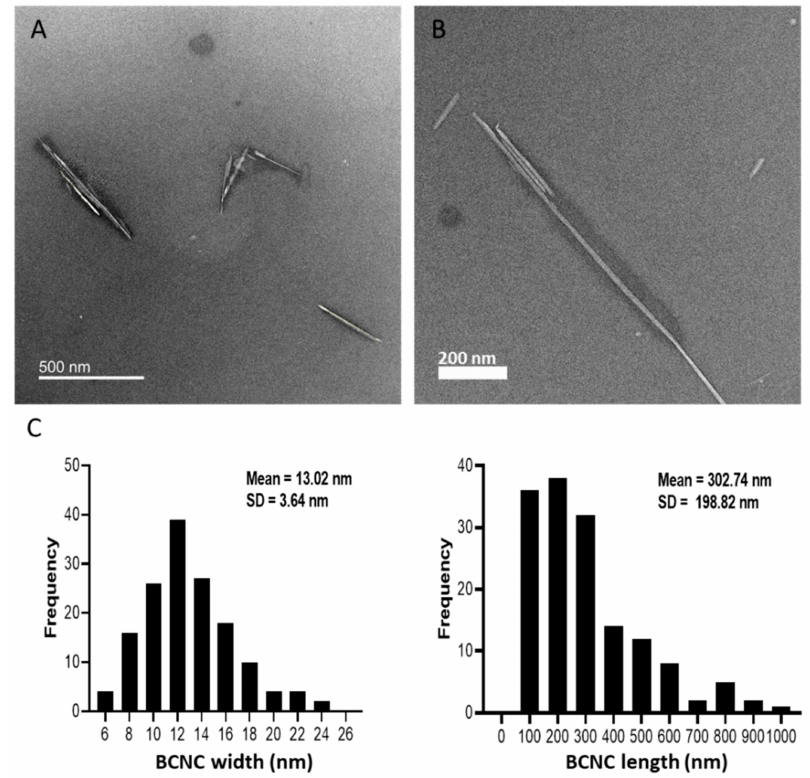
Figure 2. ( A , B ) TEM micrographs of the BCNC prepared by the acid hydrolysis of BNC and ( C ) the corresponding particle-size distributions. Scale bars: ( A ) 500 nm and ( B ) 200